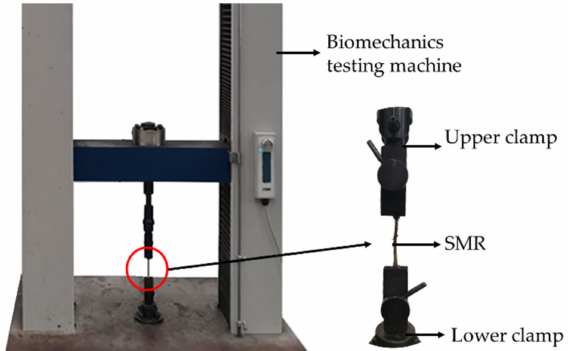
Figure 2. Tensile test by a universal testing machine.